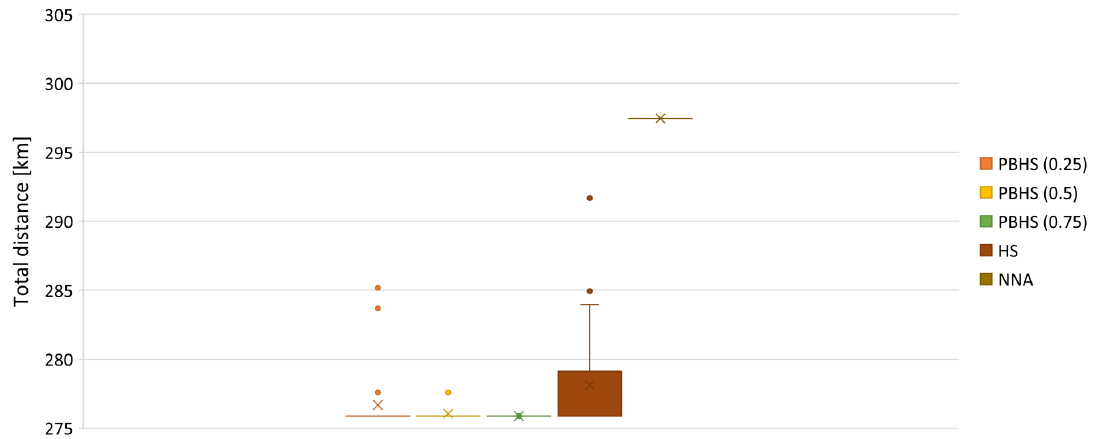
Figure 4. Comparison of results for case study (total distance).